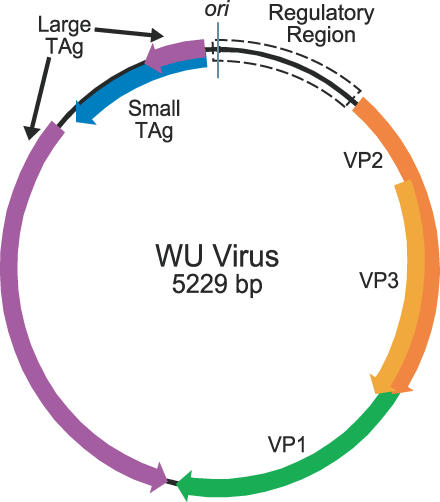
Schematic of WU Virus Genome Organizationori, origin of replication.